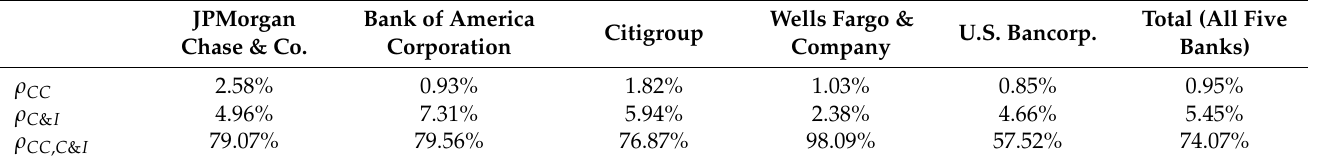
Table 5. Asset correlation